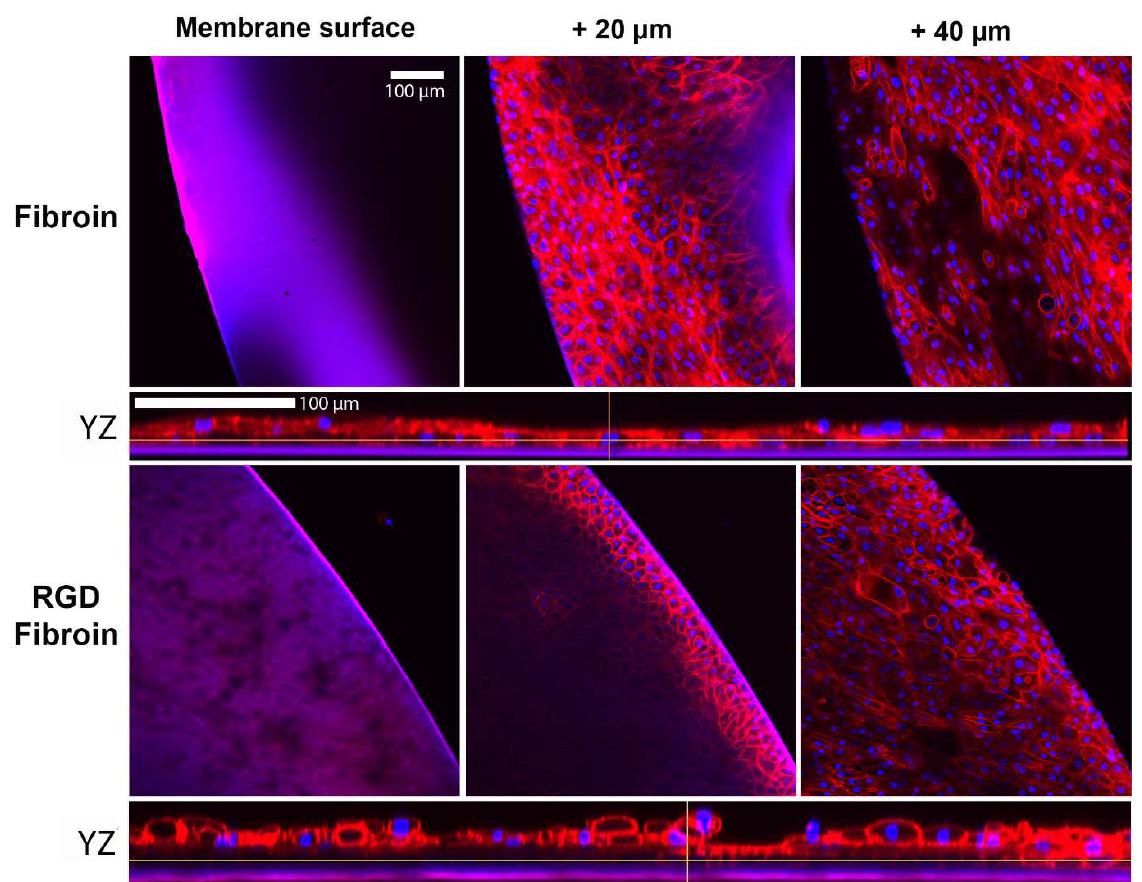
Figure 4. Evaluation of limbal epithelial cell growth (stratification) on freestanding fibroin membranes. Confocal fluores- cence micrographs demonstrate the relative thickness and confluence of basal and stratified layers for limbal epithelial cells grown on Fibroin (BMSF) membranes, compared to membranes prepared from RGD-Fibroin. Cultures were maintained in serum-supplemented growth medium for approximately 2 weeks prior to fixation in neutral buffered formalin and labelling with rhodamine phalloidin and Hoechst nuclear stain. A tighter and enhanced cobblestoned morphology is observed for the culture grown on RGD-Fibroin (as displayed at approximately +20 µm above the plane of the membrane surface). The corresponding enlarged YZ axis view is displayed underneath each set of images. The cultures grown on RGD-Fibroin membranes were also typically more stratified as demonstrated by greater confluency at +40 µm above the plane of the membrane and the overall number of layers produced (2–4 layers compared to 1–2 layers).